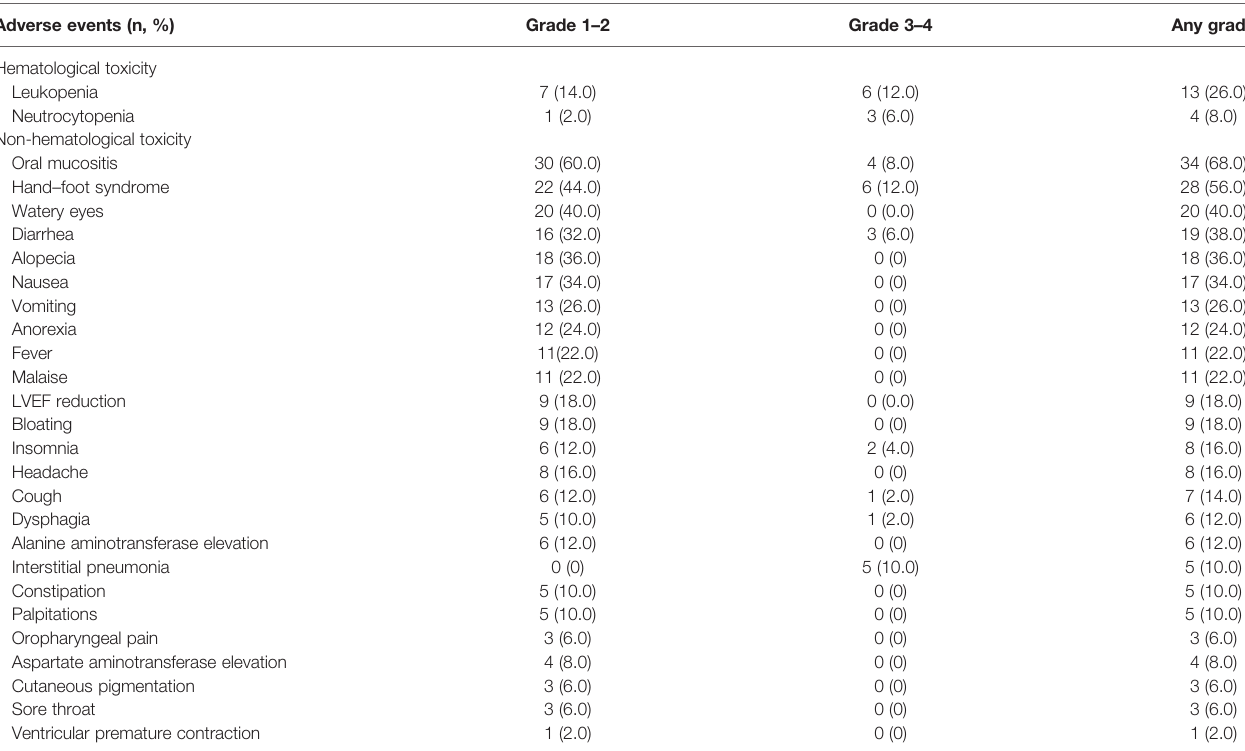
TABLE 3 | Treatment-related adverse events in all patients (n = 50).